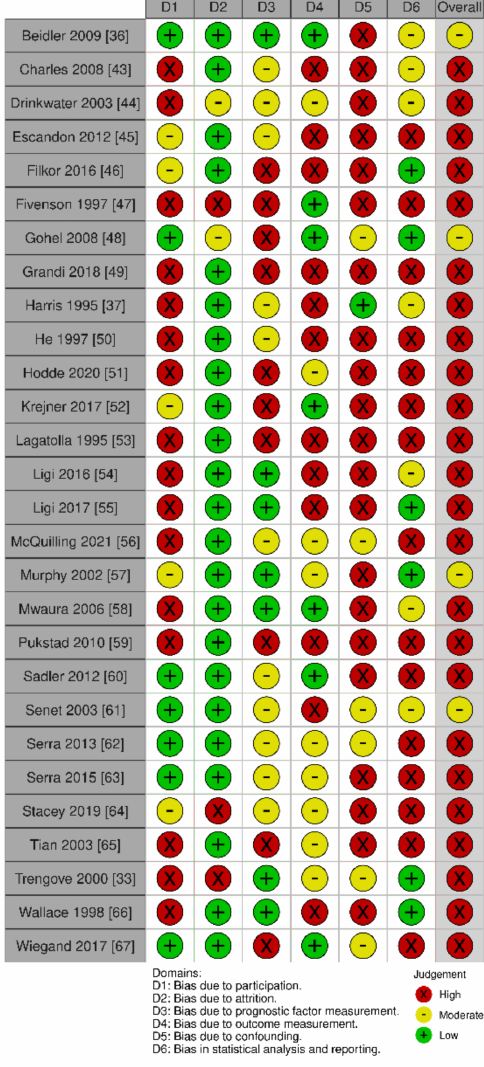
Figure 2. Quality assessment of the 28 included studies (risk of bias). The individual studies were judged in six domains (D1–D6), and each domain was judged as high, moderate or low risk of bias. An overall rating took all domains into account. The traffic-light plot was created with a tool by McGuinness et al.